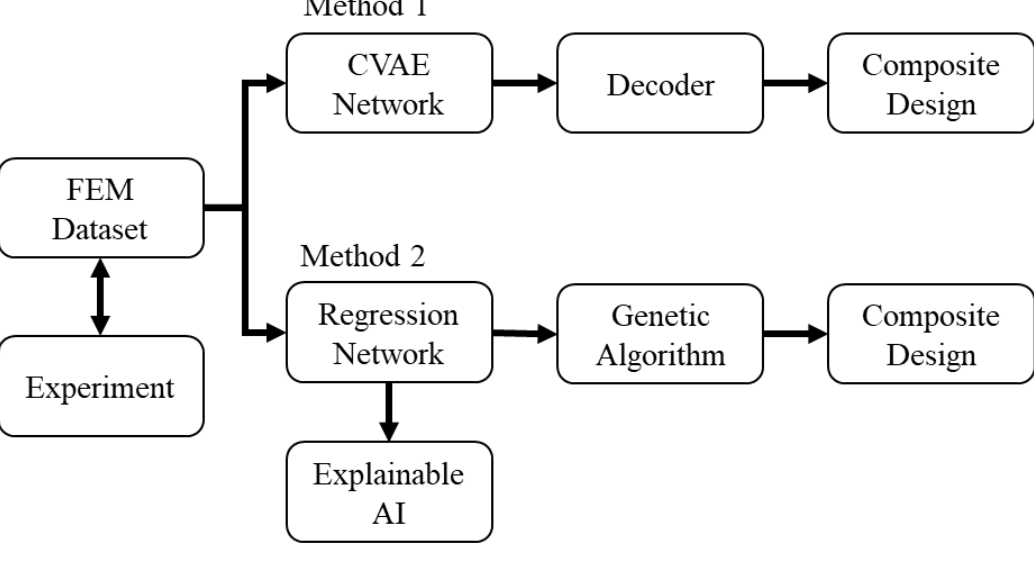
Figure 1. Overall flow chart.